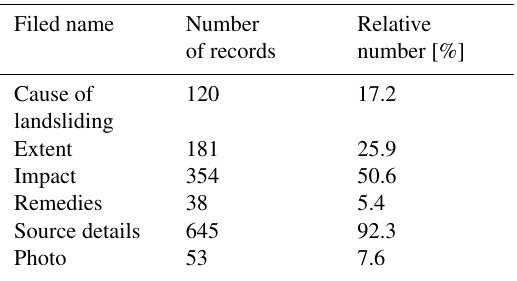
Table 2. Database completeness on the basis of particular non- mandatory